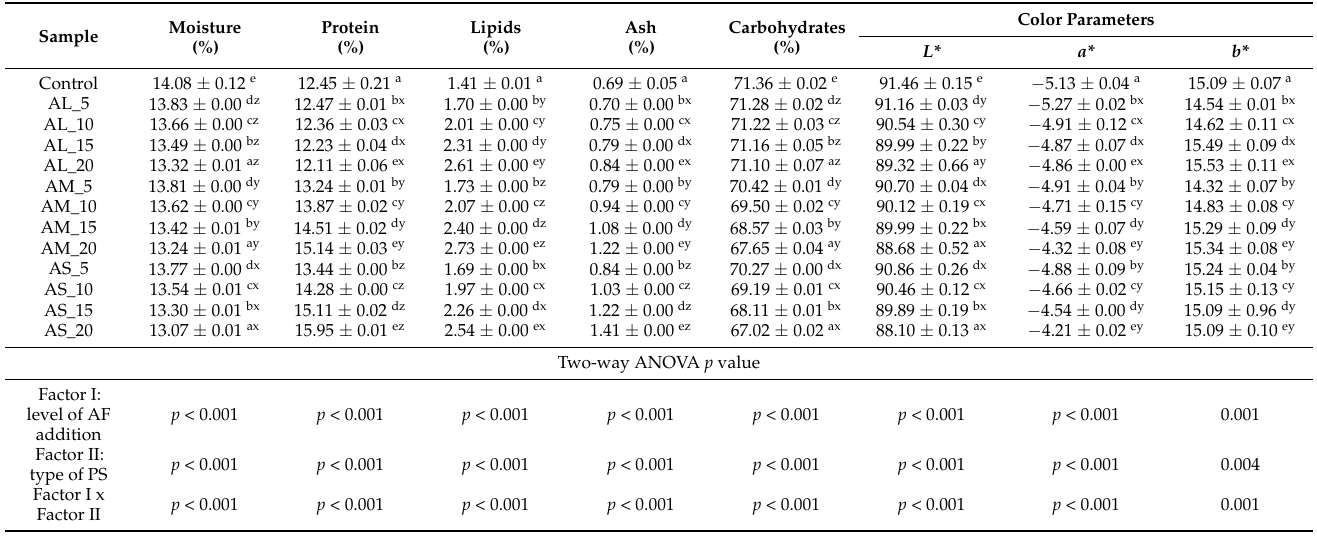
Table 2. Physicochemical properties and color parameters of wheat–amaranth composite flours compared with the control.